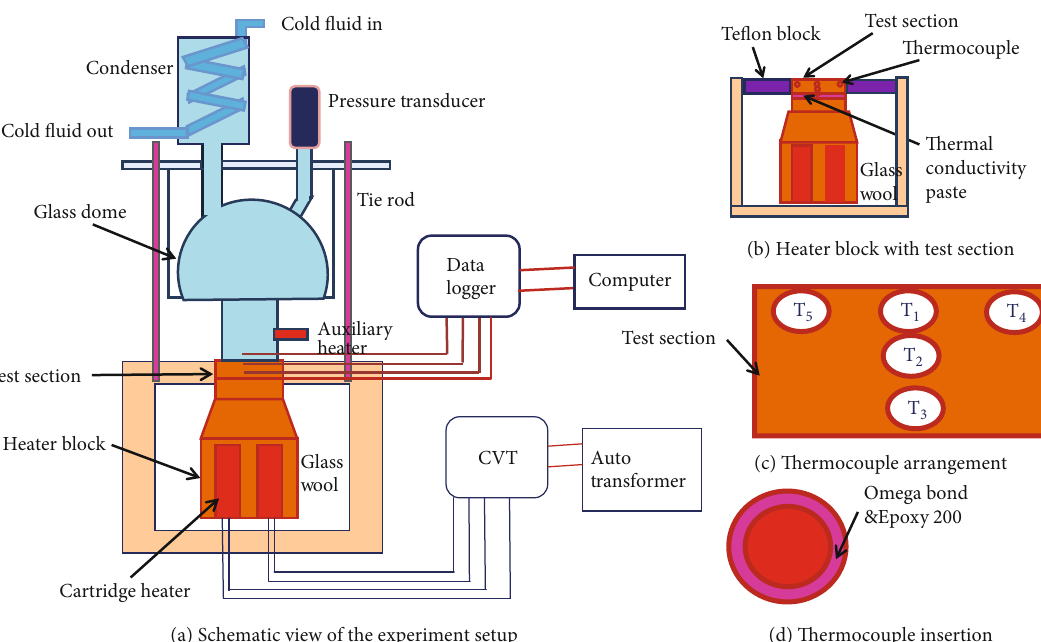
Figure 1: Pool boiling experimental